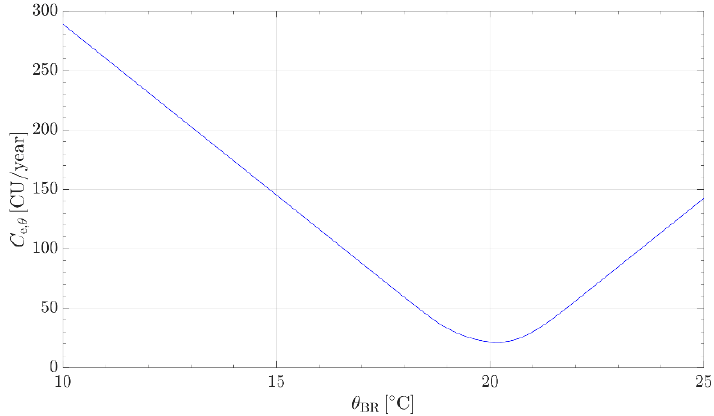
Figure 7. Annual costs of the heating, ventilation, and air conditioning (HVAC) device in the battery room (BR) for various BR temperatures in a small substation.